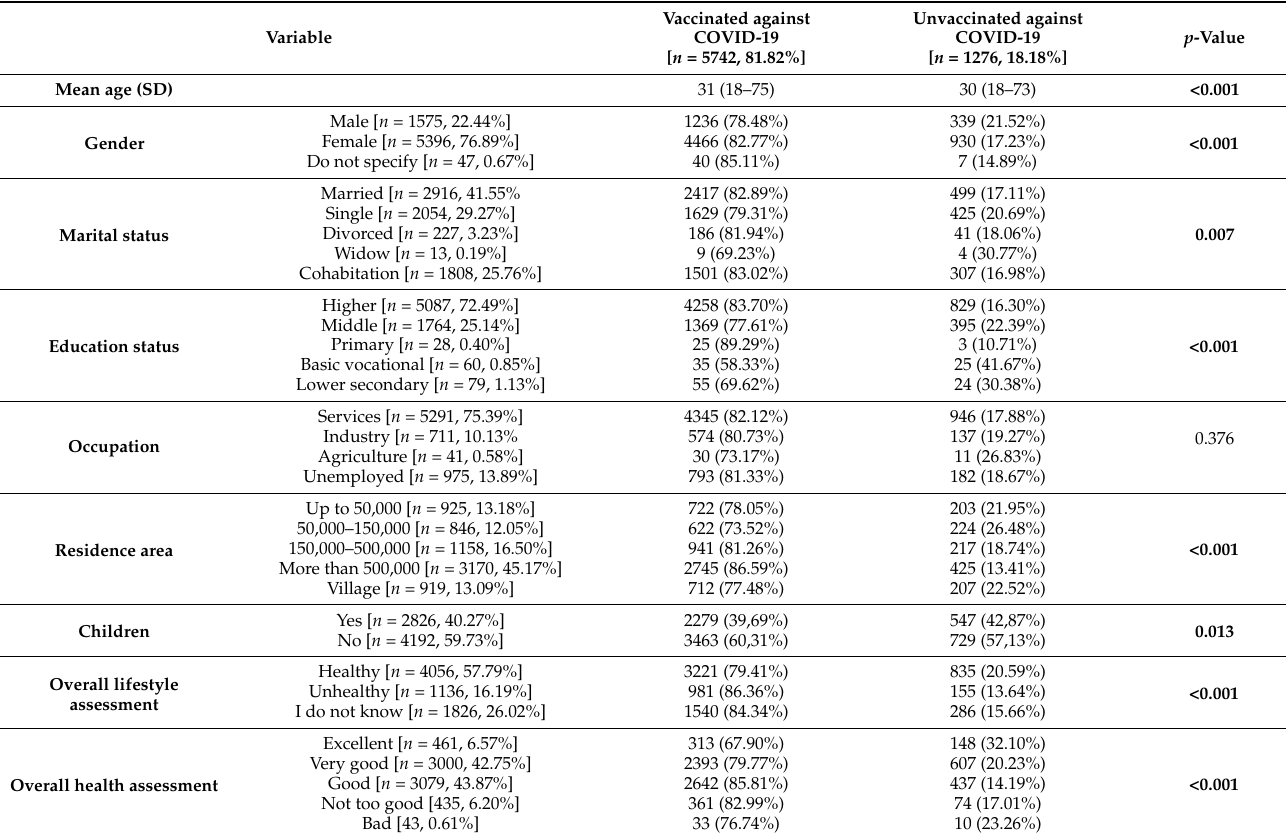
Table 1. Participants